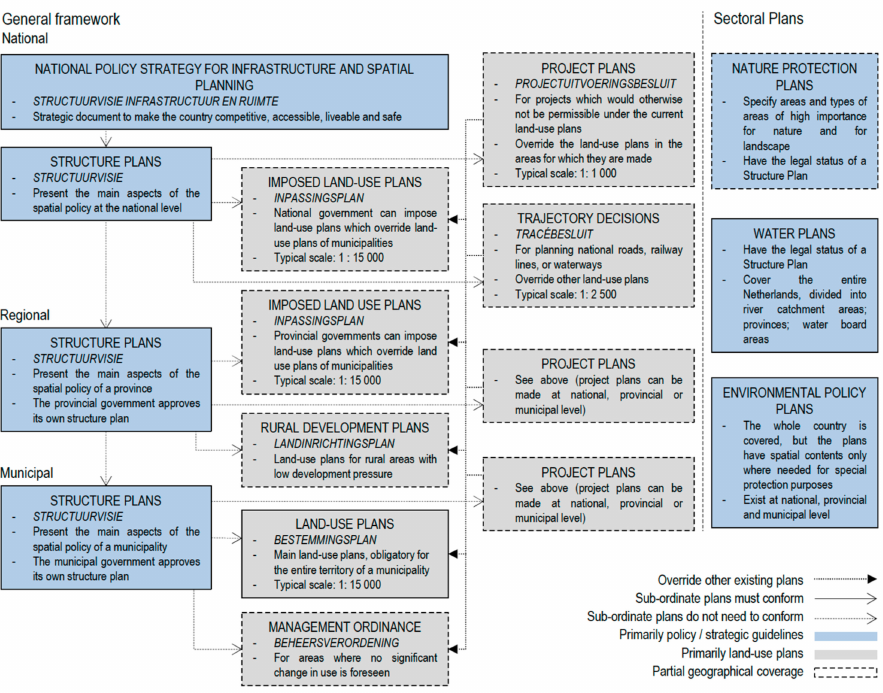
Figure 8. Organisation of spatial and land-use planning in the Netherlands